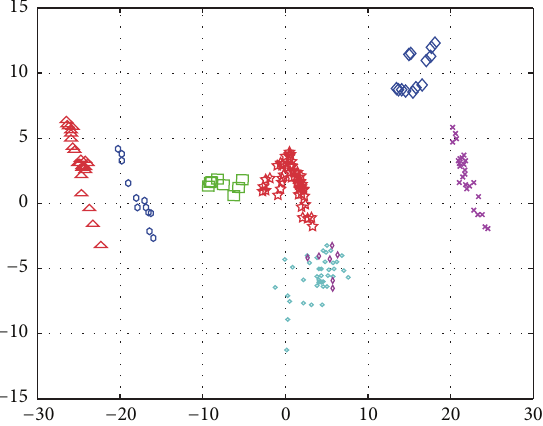
Figure 11: Clustering results obtained by ISODATA.